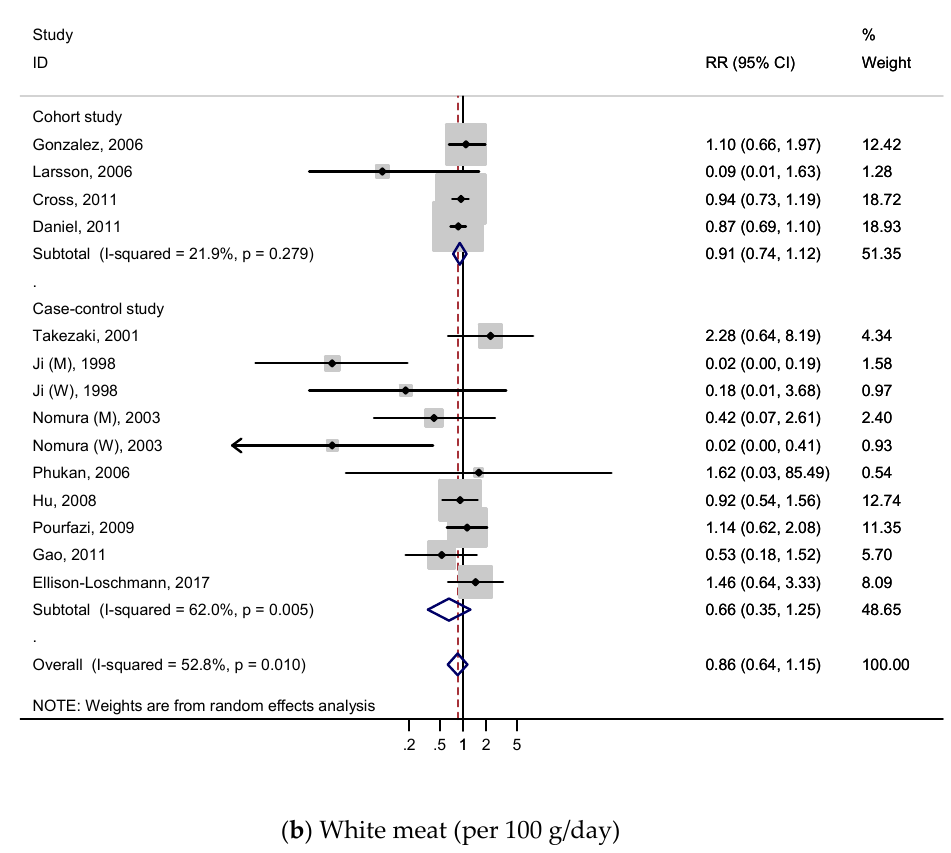
Figure 4. Adjusted relative risks and 95% confidence intervals of gastric cancer for white meat consumption. Squares indicate each study’s relative risks. Horizontal lines indicate 95% confidence intervals. Diamonds indicate the summary relative risks and 95% confidence intervals. ( a ) Highest versus lowest categories of white meat consumption; ( b ) dose–response meta-analysis for 100 g / day increase in white meat consumption.